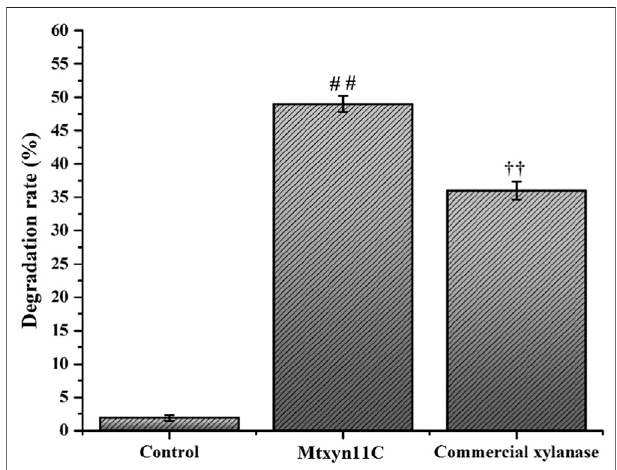
FIGURE 4 | Degradation ef fi ciency of Mtxyn11C and commercial xylanase towards BWX. Data represent mean ± SD of the independent triplicates. # #, †† indicates p < 0.05.